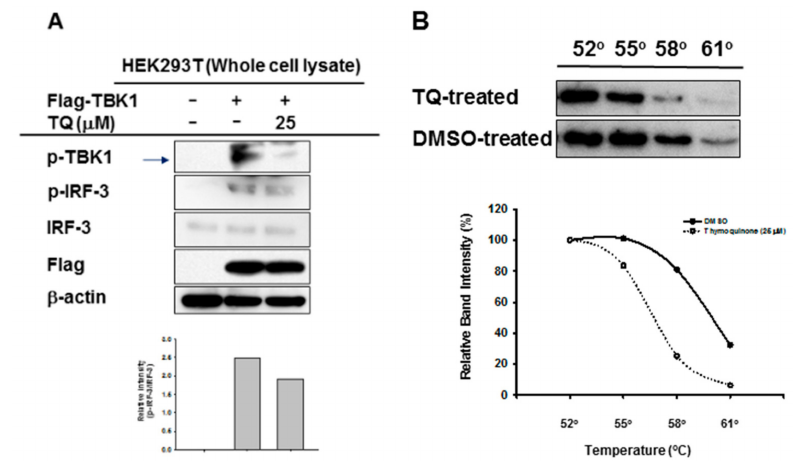
Figure 5. TQ inhibits autophosphorylation of TBK1. ( A ) HEK293T cells (2 × 10 6 cells/mL) were transfected with Flag-TBK1 (0.8 µ g/mL) for 24 h, followed by TQ (25 µ M) treatment for an additional 24 h without changing media. The level of p-TBK1, the total level of Flag-TBK1, and the phospho- and total levels of IRF-3 were determined by immunoblotting; ( B ) RAW264.7 cells (2 × 10 6 cells/mL) were pre-incubated overnight, followed by additional incubation with TQ 25 µ M or DMSO for 30 min. Cellular Thermal Shift Assay (CETSA) Classic was performed at four different heating temperatures as indicated. Cell lysates were immunoblotted with a TBK1